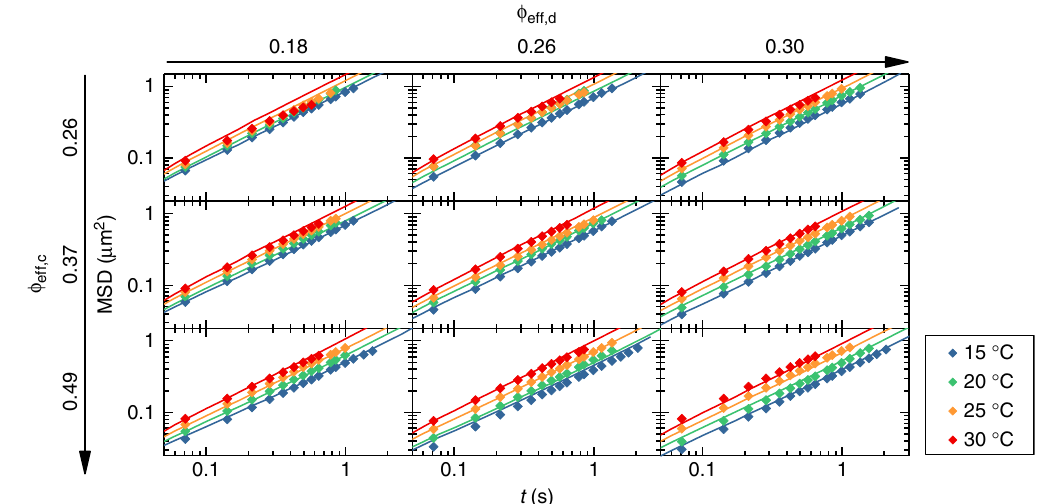
Fig. 4 Experimental and numerical mean square displacements for all investigated state points. Diamonds denote 2D experimental data ( 〈 x 2 + y 2 〉 ), while solid lines represent the corresponding simulation results based on the MH model. The color legend applies to the entire graph. Values of ϕ eff,c and ϕ eff,d at 15 °C are given for each row and column, respectively. For higher temperatures, the values of ϕ eff,c , ϕ eff,d can be found in Table